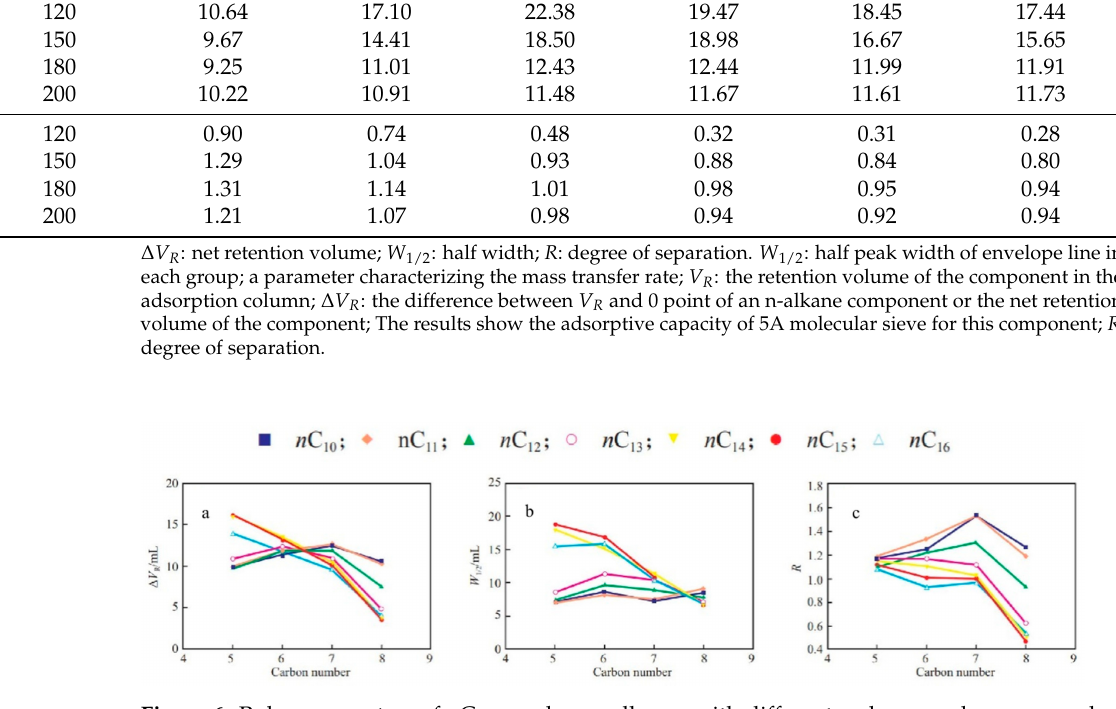
Figure 6. Pulse parameters of nC 10–16 when n-alkanes with different carbon numbers are used